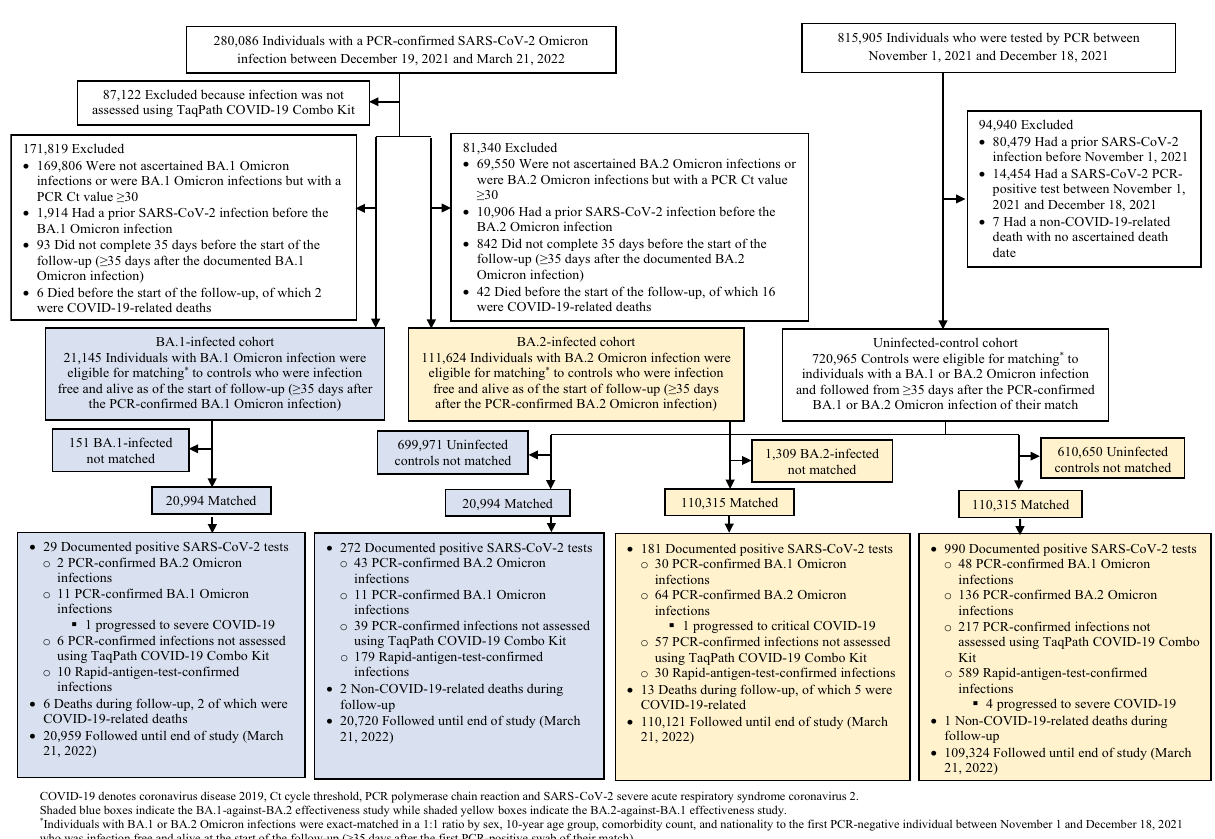
Fig. 2 | Population selection process. Cohort selection in the BA.1-against-BA.2 and BA.2-against-BA.1